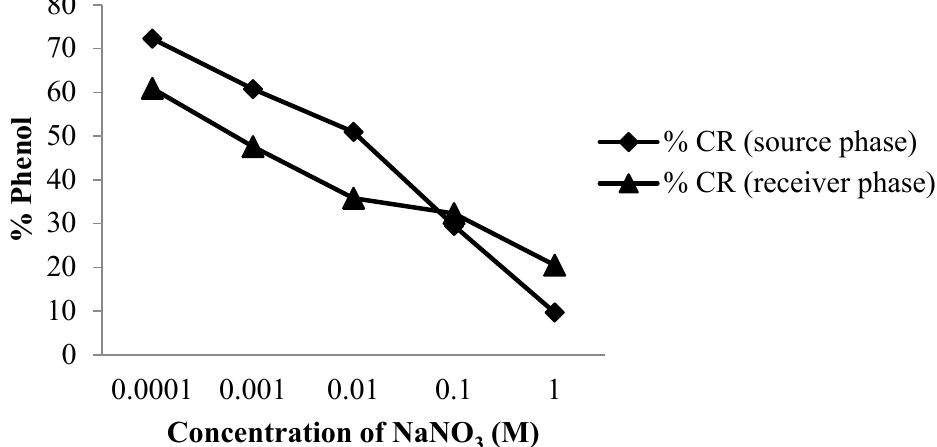
Figure 8. Graph of the effect of NaNO 3 salt concentration in the source phases and the phenol in the receiver phase.